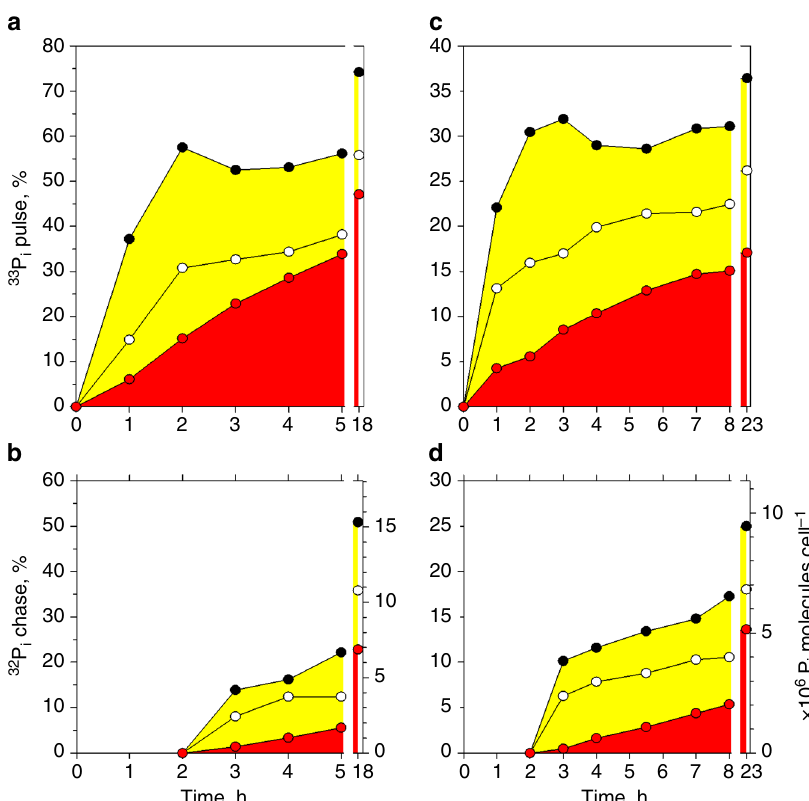
Fig. 3 P i accumulation by Synechococcus sp. WH8102. Left ( a , b ) and right ( c , d ) panels show the results of two representative pulse-chase experiments with cells at exponential and early stationary growth phases, respectively. a , c Accumulation dynamics of 10 − 8 mol l − 1 33 P i -pulse added at 0 h in live cells washed with arti fi cial seawater − the total P i (black circles), live cells washed with deionized water − the cytoplasmic P i (white circles) and in the PFA- fi xed cellular biomass − the macromolecule-bound P i (red circles), as a percentage of added tracer. b , d Accumulation dynamics of the 10 − 6 mol l − 1 32 P i -chase added at 2 h as the total P i , the cytoplasmic P i and the macromolecule-bound P i . The additional right Y-axis ( b , d ) shows cellular rates of 32 P i -chase accumulation. To assist comparison of the labile and non-labile P i , the areas below lines are coloured yellow for the labile P i and red for non-labile P i . Symbols are connected with lines to indicate the slopes of the 33 P i and 32 P i tracer accumulation. The X-axis is broken to add an additional, fi nal time point. Circles present mean values of technical duplicates or individual measurements. Source data are provided as a Source Data fi